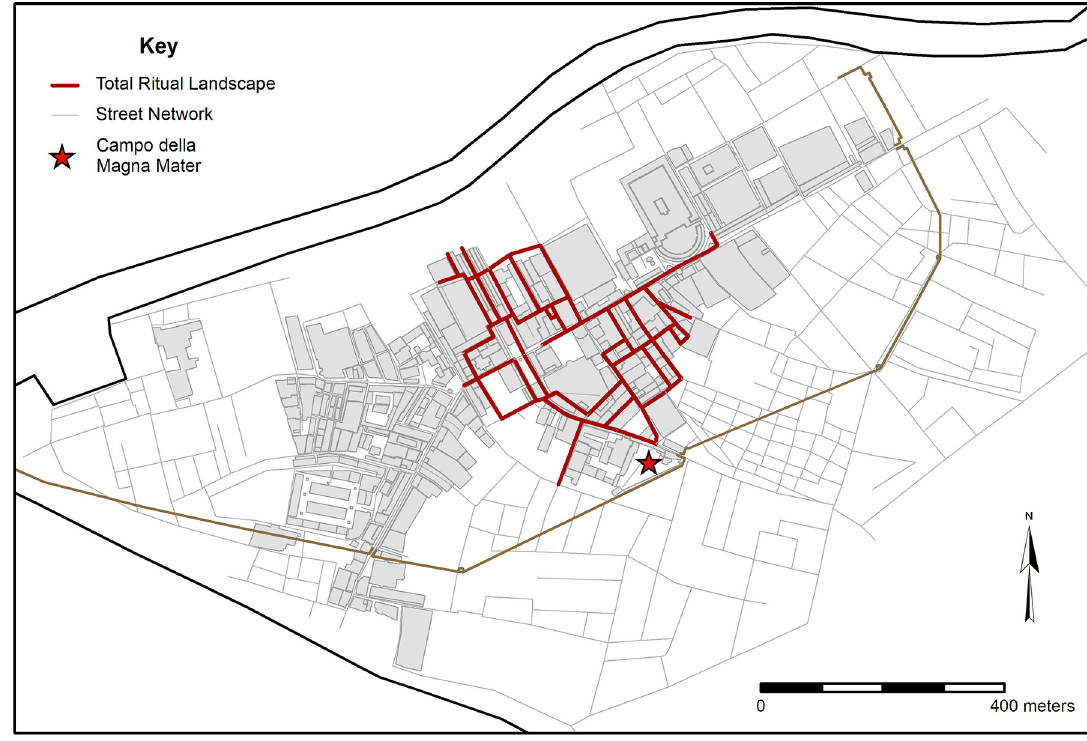
Figure 14. Map showing the total processional area structured around the Campo della Magna Mater following the most likely processional movement